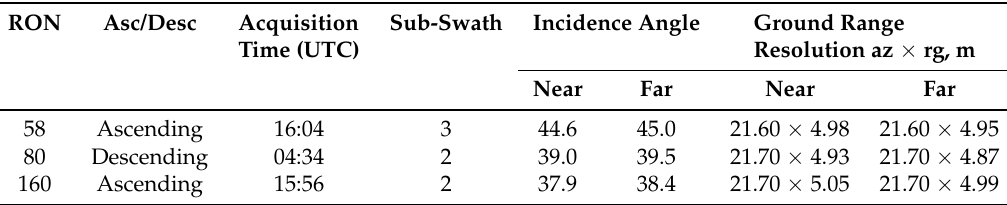
Table 1. Relative orbit numbers (RONs) used in the study and their parameters [33]. The values are given for the study area. Azimuth (az), range (rg).